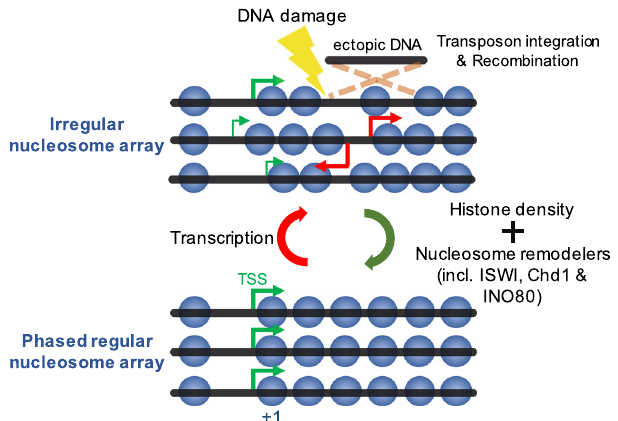
Fig. 8 Model for biogenesis and function of regular nucleosome arrays. Transcription is strongly disruptive to nucleosome arrays and it takes ISWI-, Chd1- and/or INO80- remodelers to reinstate array architecture. Proper histone density is indispensable for spacing as neither DNA sequence-based nucleosome positioning nor the clamping activity of remodelers suf fi ces. Remodelers also position the + 1 nucleosome, thereby sharpening the site of transcription initiation (green arrows). Regularly spaced nucleosome arrays prevent cryptic transcription (red arrows), DNA damage, ectopic recombination and transposon integration within the gene